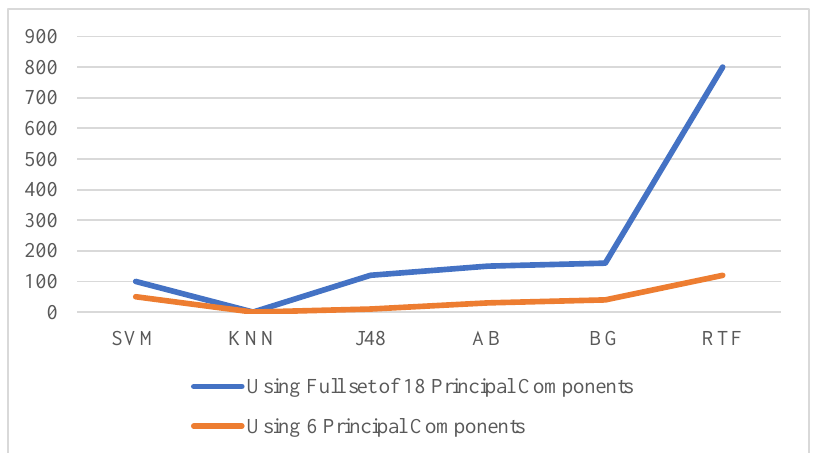
Figure 7. Comparison of the model ’ s training time (in milliseconds).